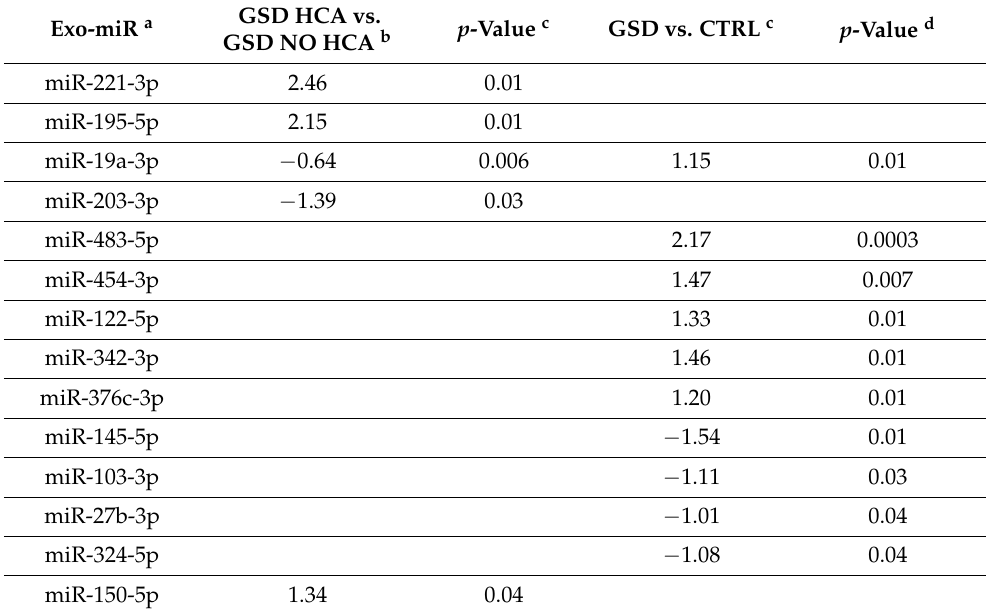
Table 2. Differentially expressed Exo-miRs in GSDIa